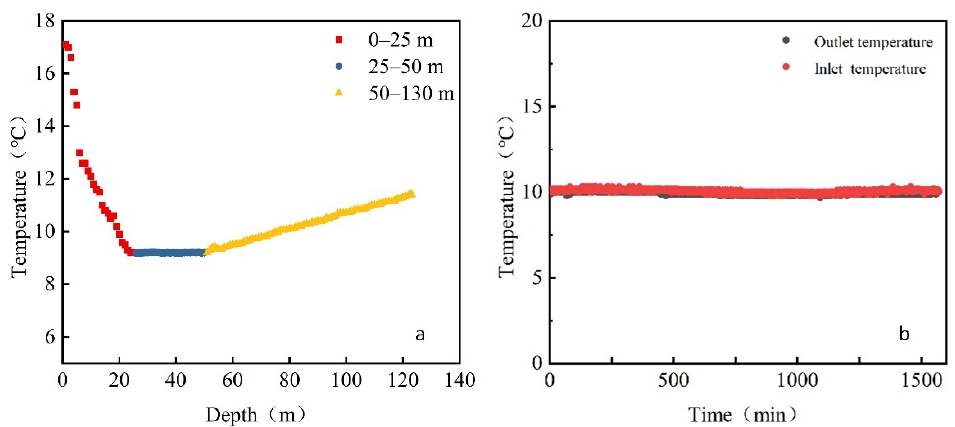
Figure 4. Undisturbed formation temperature. ( a ) Temperature distribution with the depth. ( b ) Stable inlet and outlet temperatures after water circulation initiation.